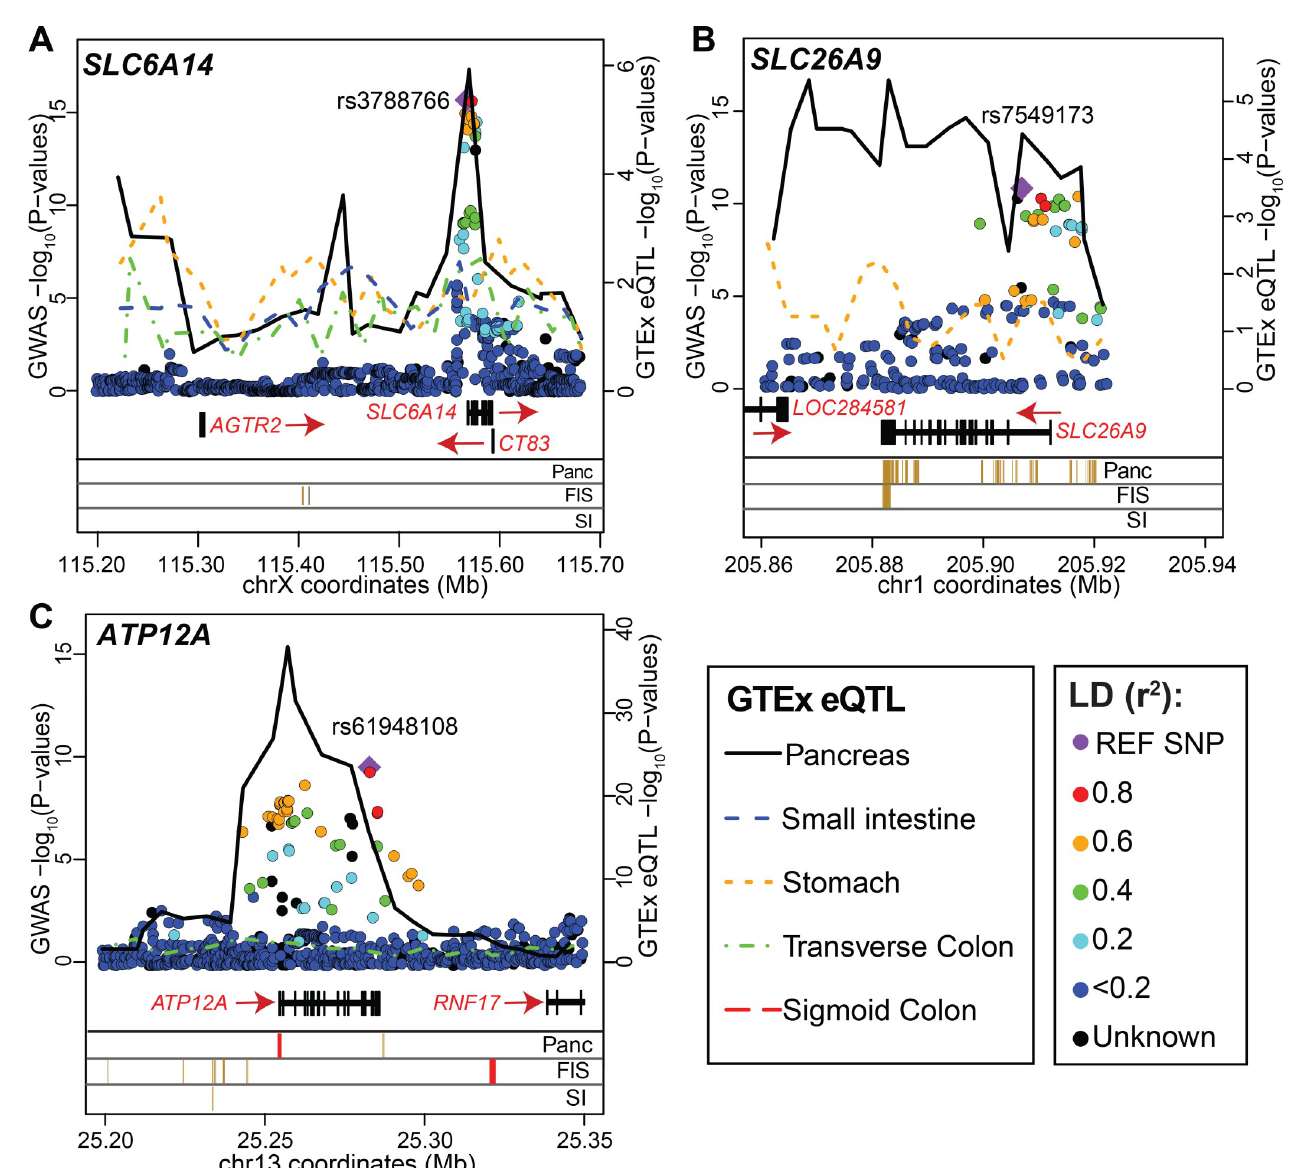
Fig 2. Overlay of the p-values of individual SNPs from the meconium ileus GWAS and GTEx eQTL association and the enhancer and promoter states from the REMC at the three genome-wide significant loci. All the p-values are on the–log 10 scale with the left y-axis representing the GWAS (with the filled diamond for the SNP with the lowest p-value and colored dots indicating the LD with this SNP) and the right y-axis representing the GTEx eQTL results (version 7; with colored lines indicated for different tissues) for SLC6A14 (A), SLC26A9 (B), and ATP12A (C). Note that eQTLs for SLC6A14 in the pancreas and ATP12A in the transverse colon were not mapped by GTEx v7, but were calculated and included here—refer to Material and Methods, GTEx Data section for details. To display the eQTL data, each physical region shown was divided into 25 equal windows and lines were drawn for each tissue by connecting the minimum GTEx eQTL p-value within each window for that gene. The absence of a line indicates insufficient gene expression for that particular tissue (see GTEx Data section for details on expression threshold). In the lower panels, the 5-mark 15-state observed chromHMM enhancer (orange) and promoter (red) states within DNase hypersensitive sites are shown (Material and Methods) from adult pancreas (Panc), fetal small intestine (FIS) and adult small intestine (SI).